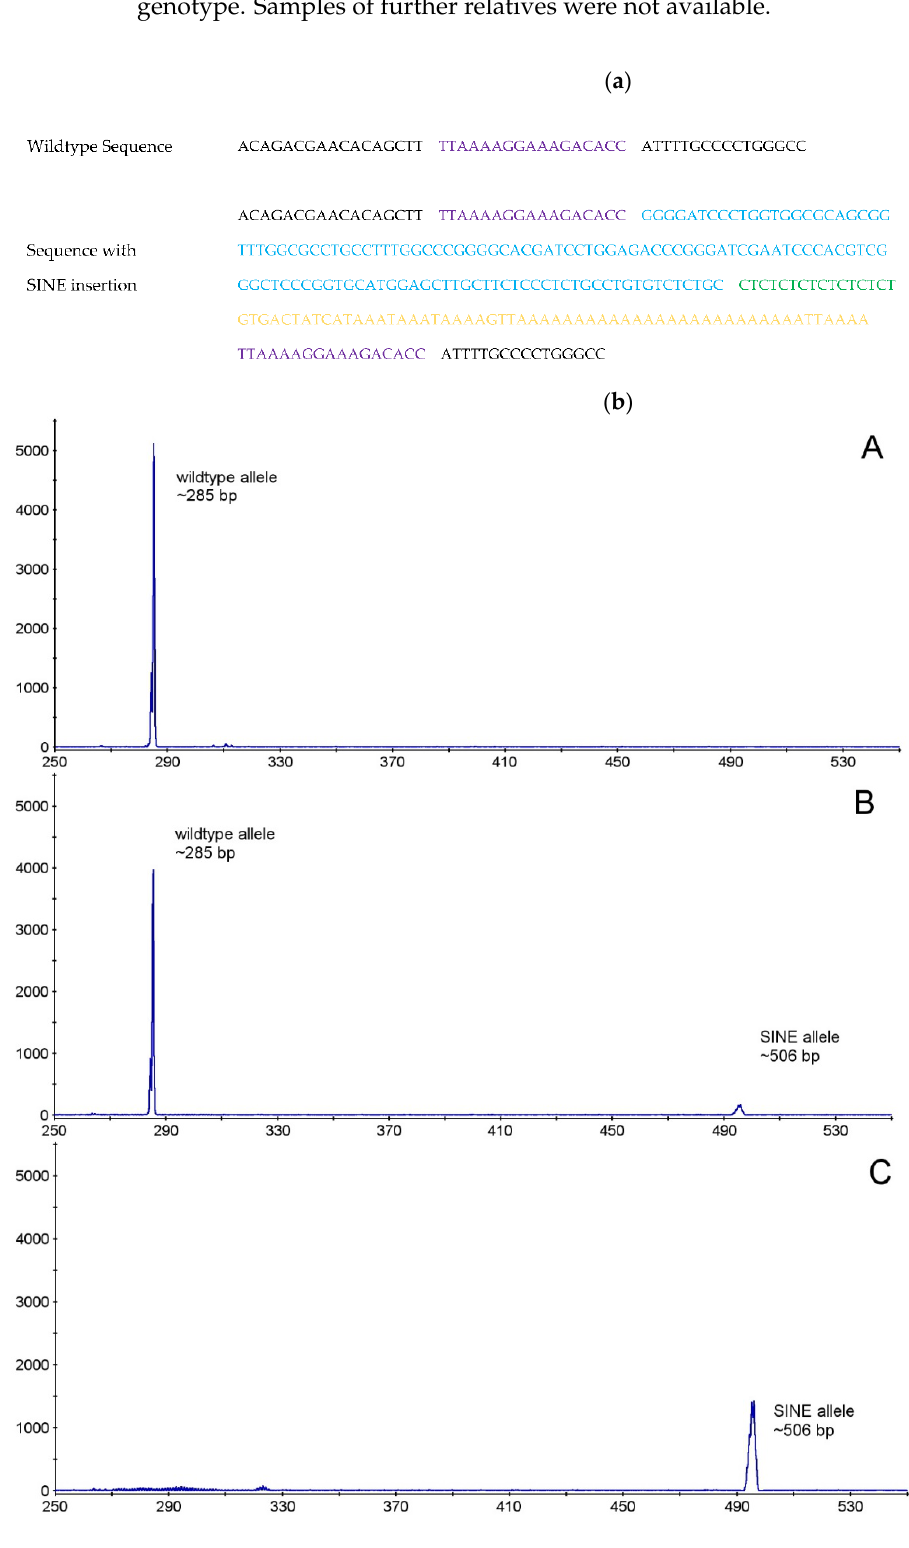
Figure 1. ( a ) Nucleotide sequence of the c.4824_25ins221 variant in exon 14 of F8 gene of affected dogs. Black nor- mal wildtype sequence, violet direct repeat, blue short interspersed nucleotide insertion (SINE), green (CT) 8 stretch, yellow poly(A) tract ( b ) Fragment length polymorphism analysis of a wildtype (lane A), carrier (lane B) and affected (lane C) dog. Expected PCR product length without SINE 285 bp, with SINE ~506